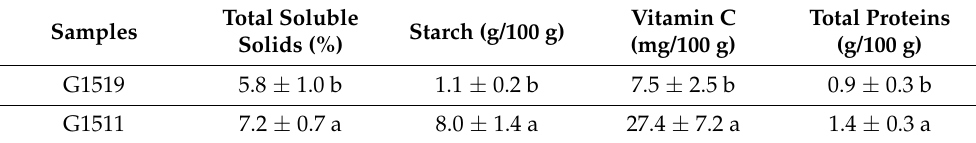
Table 1. Quality characteristics of different pumpkin varieties.